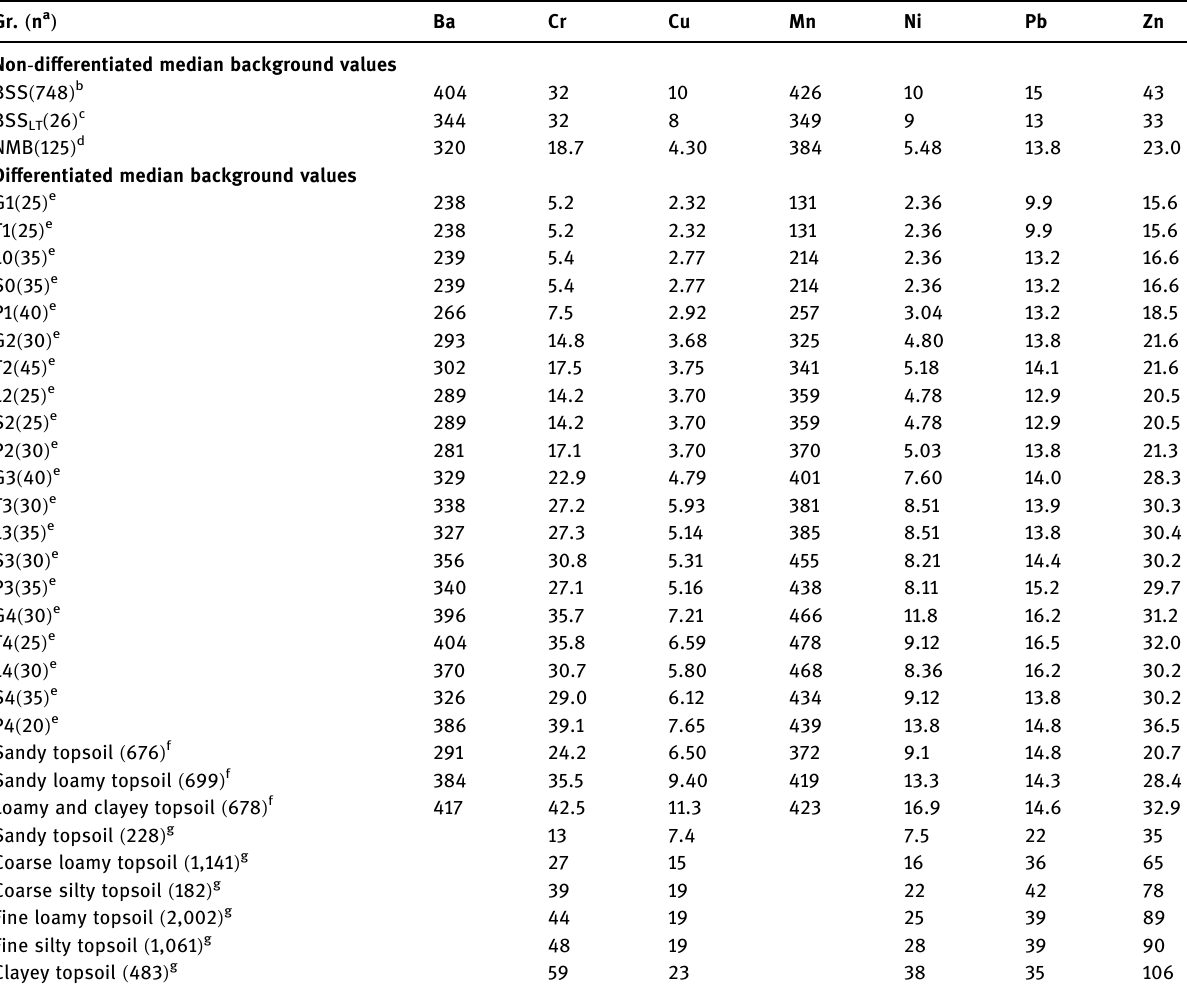
Table 6: Non - di ff erentiated and di ff erentiated median background values ( mg kg − 1 ) of PHEs in topsoil compared to values given in some other